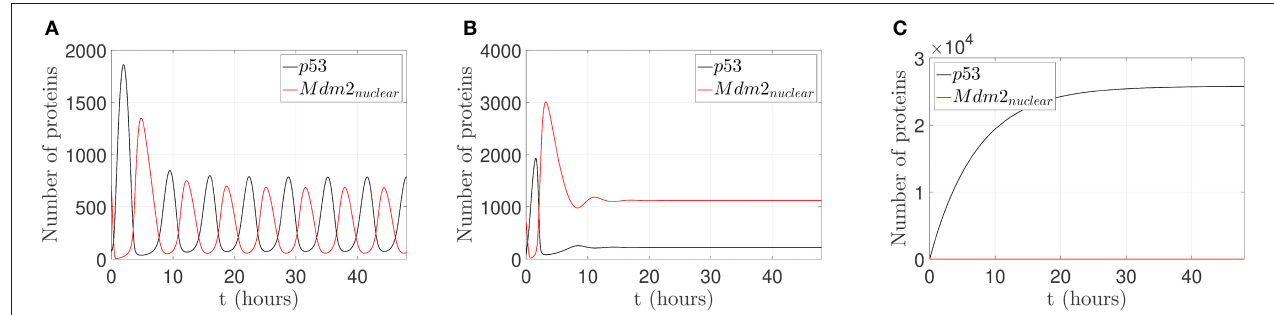
FIGURE 3 | Behaviors of the p53-Mdm2 network regulated by p14ARF without control action. (A) p53-Mdm2 nuclear oscillatory pattern under gamma-radiation within a lapse of 6.64 h. (B) Mdm2 nuclear overexpression and p53 downregulation with k 1 = 1.9926 × 10 − 6 /s and k 2 = 45 × 10 − 3 /s; once Mdm2 nuclear is overexpressed, p53 is inhibited. It can be conjectured that Mdm2 nuclear deregulation will lead to oncogenic behavior through p53 suppression. (C) Increased expression of p53 levels response under gamma-radiation induction with k a = 5 proteins/s and d rc = 1.444 × 10 − 2 /s. It can be conjectured that p53 upregulation will lead to cell cycle arrest, DNA repair, senescence, and/or apoptotic response.